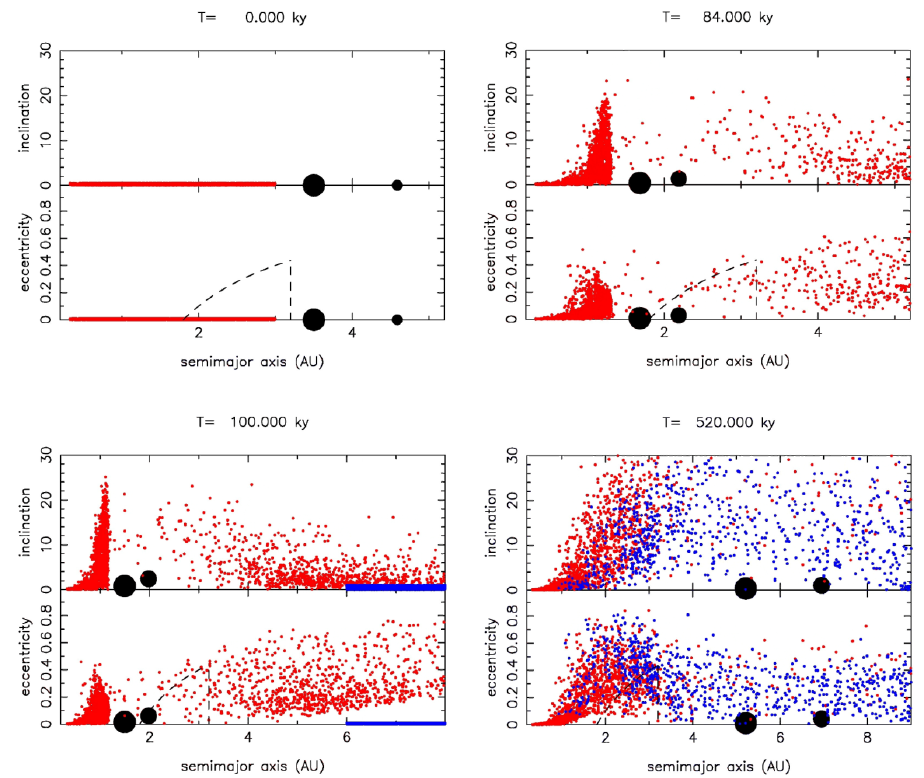
Figure 4. Distribution of inclination (upper boxes) and eccentricity (lower boxes) of the orbit of volatile-poor (red dots) and volatile-rich (blue dots) objects at different stages of the migration of the two giant planets Jupiter and Saturn (black disks), according to a simulation performed using the Grand Tack–Nice model. The time elapsed since the start of Jupiter’s migration is reported in each panel. Note the presence, at the final time point, of volatile-rich (carbonaceous) objects in the inner parts of the Solar System and volatile-poor (rocky) objects in the outer parts (Credit: Kevin J. Walsh, Southwest Research Institute, Boulder, USA and Sean N. Raymond, Laboratoire d’Astrophysique, Univ. Bordeaux, CNRS, France).